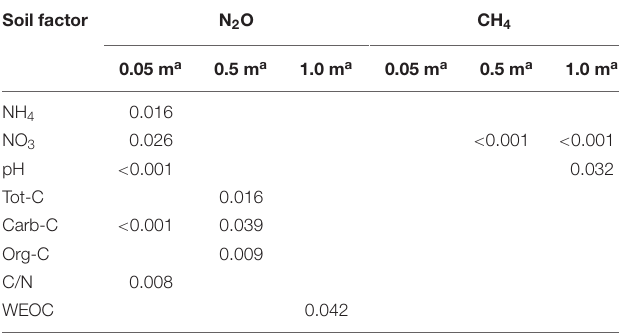
TABLE 2 | Linear relationships ( p -values) between nitrous oxide (N 2 O) and methane (CH 4 ) fluxes and soil properties at the three soil water suction heads: − 0.05 m (near water-saturated), 0.5 m, and 1.0 m water